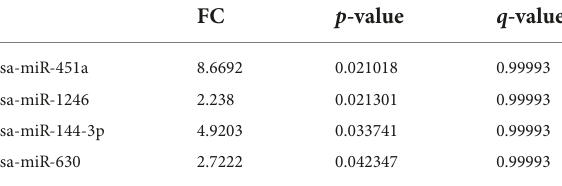
TABLE 4 miRNAs differently expressed according to clinical outcome at 3 months.